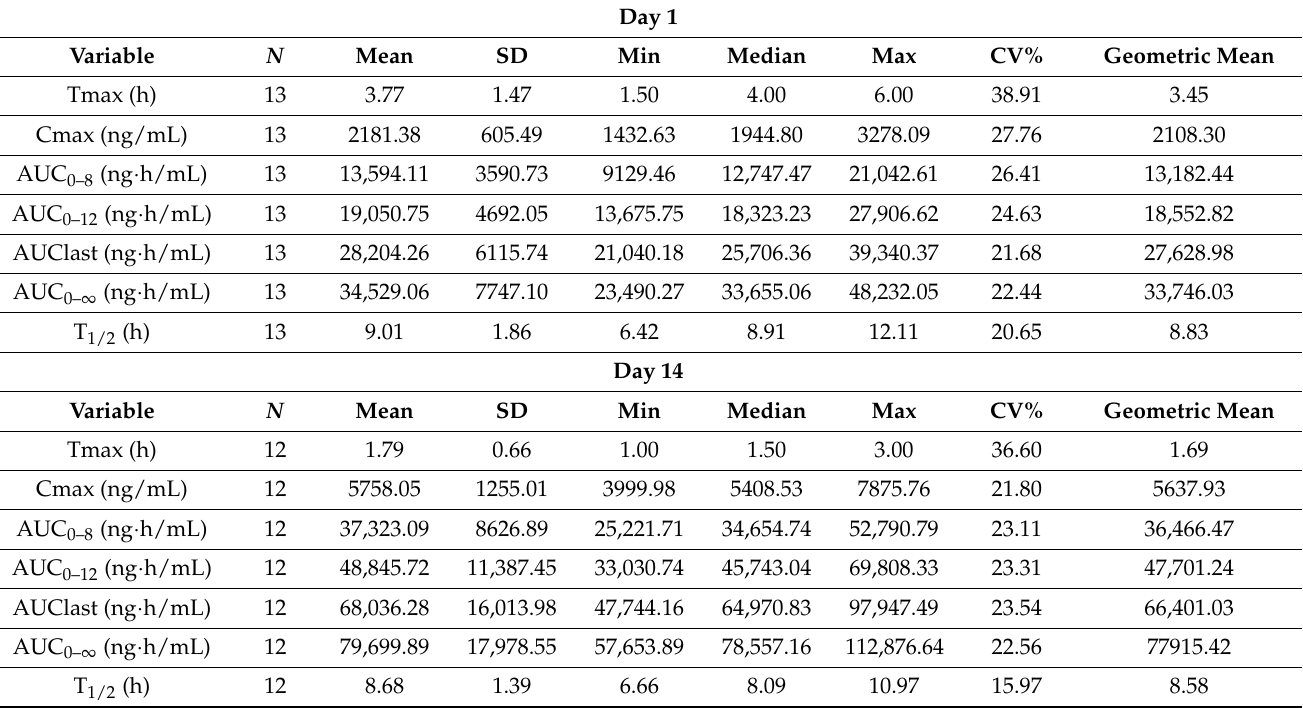
Table 3. Meprobamate pharmacokinetic parameters after single (350 mg) or multiple carisoprodol doses (up to 350 mg/8 h. 14 days).